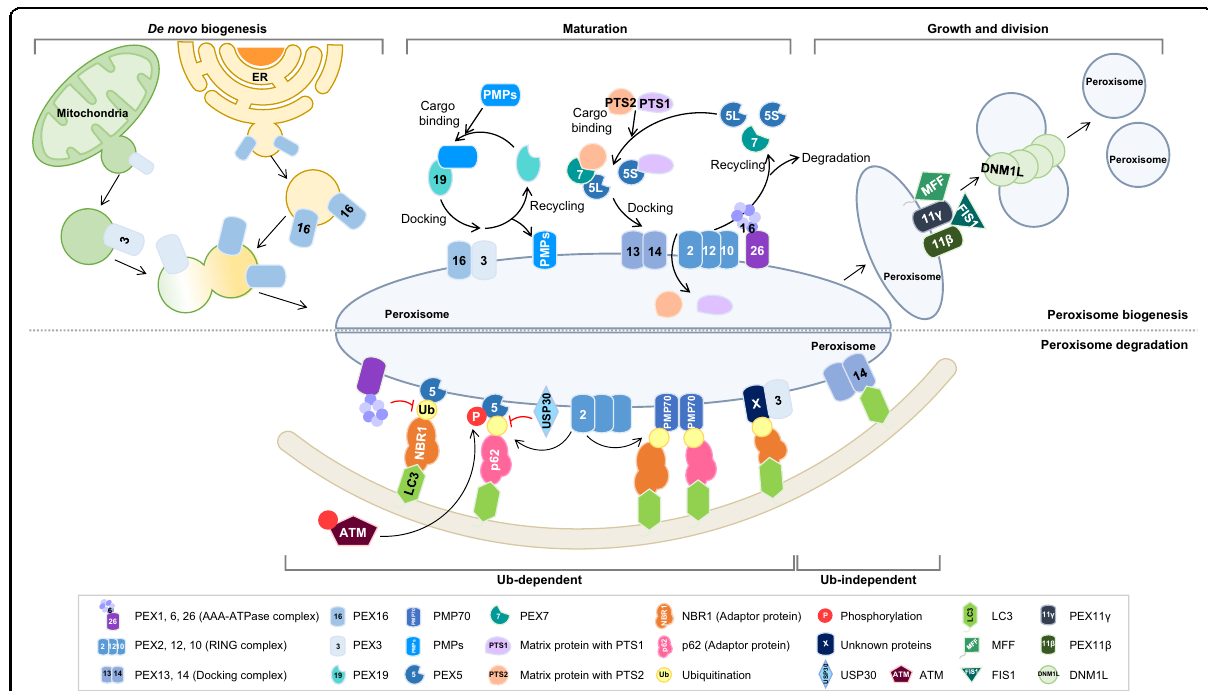
Fig. 1 Schematics of the peroxisome biogenesis and degradation systems. The number of peroxisomes is regulated by de novo biogenesis and the growth and division of pre-existing organelles. First, peroxisomes can be formed by the maturation of preperoxisomal vesicles that emerge from the ER or mitochondria and contain peroxisomal membrane proteins, including PEX16, PEX3, and PEX14. Preperoxisomal vesicle fusion results in the generation of mature peroxisomes mediated by PEX19. Second, peroxisomes can be formed by the elongation and division of mature peroxisomes, which are cleaved by the proteins PEX11, Fis1, MFF, and DNM1L (top). Pexophagy is regulated by ubiquitination-dependent and ubiquitination- independent pathways. The ubiquitination of the cytosolic region of peroxisomes triggers their degradation by pexophagy. During oxidative stress, ATM interacts with and phosphorylates PEX5, which promotes PEX5 ubiquitination by PEX2. Ubiquitinated PEX5 is recognized by p62, which recruits the autophagosome. The peroxisomal AAA-type ATPase complex, PEX1, PEX6, and PEX26, prevents pexophagy by regulating the accumulation of ubiquitinated PEX5. During amino acid starvation conditions, PEX2 regulates the ubiquitination of PEX5 and PMP70, increasing pexophagy in an NBR1-dependent manner. USP30 prevents pexophagy by counteracting PEX2. In contrast, PEX14 directly interacts with LC3 under nutrient deprivation conditions